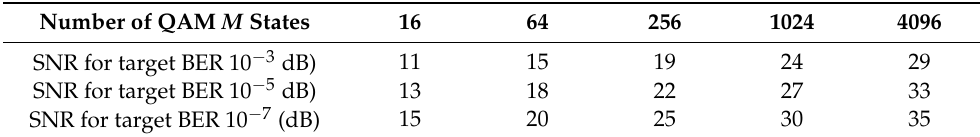
Table 6. SNR values with targets of BER considering M-QAM